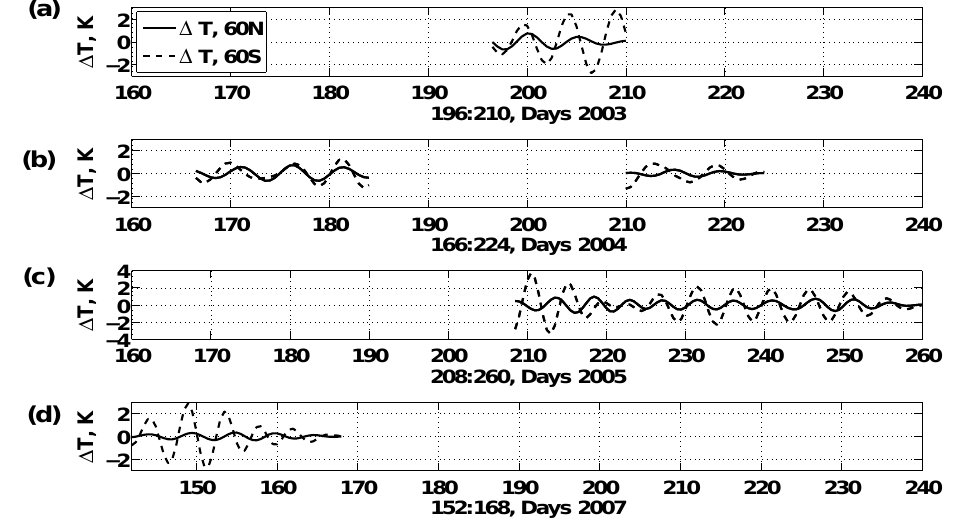
Fig. 2. 5-day perturbations from Odin temperature retrievals. Solid lines are for 60 ◦ N, dashed lines are for 60 ◦ S. (a) for period 15–27 July 2003; altitude=38km, longitude=21 ◦ E. (b) for period 14 June–11 August 2004, altitude=40km, longitude=16 ◦ E. (c) for period 27 July–17 September 2005, altitude=42km, longitude=21 ◦ E. (d) for period 22 May–17 June 2007, altitude=46km, longitude=21 ◦